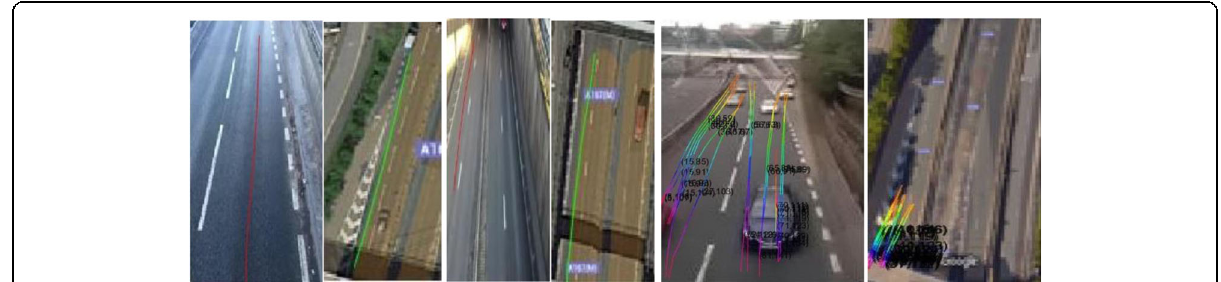
Fig. 11 Smoothed vehicle trajectories by applying Bezier curve